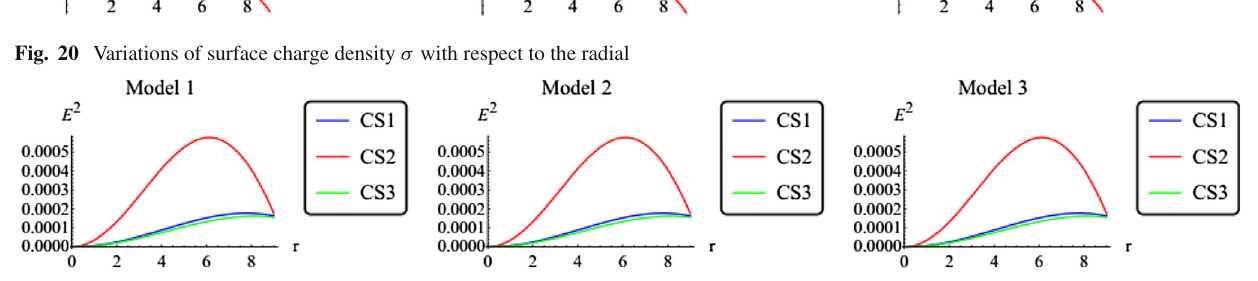
Fig. 21 Variations of electric field square E 2 with respect to the